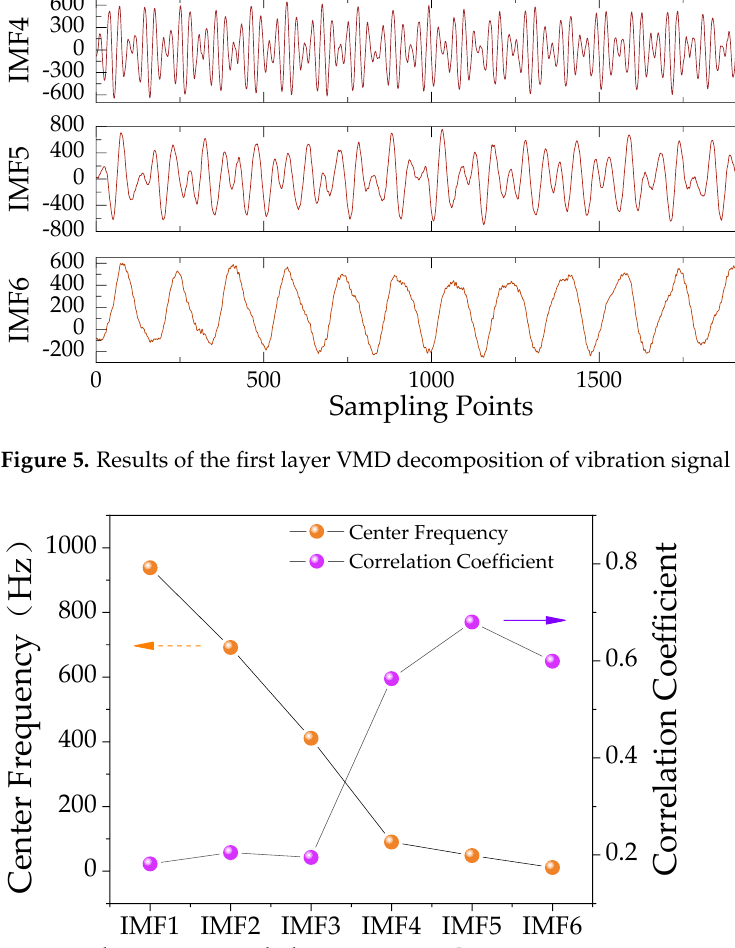
Figure 6. The first layer VMD decomposes the correlation coefficient of each IMF component with the signal superimposed noise and the center frequency of each mode. the signal superimposed noise and the center frequency of each